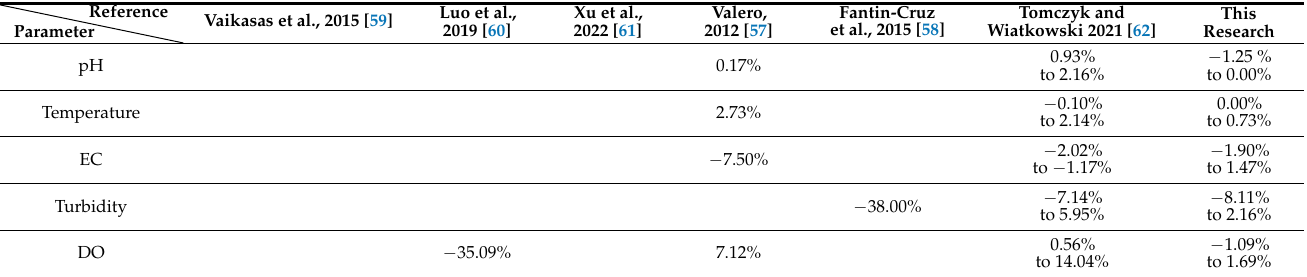
Table 14. Comparison of the results obtained for physicochemical parameters within different hydropower plants (difference in medians at points downstream and upstream of hydropower plants)